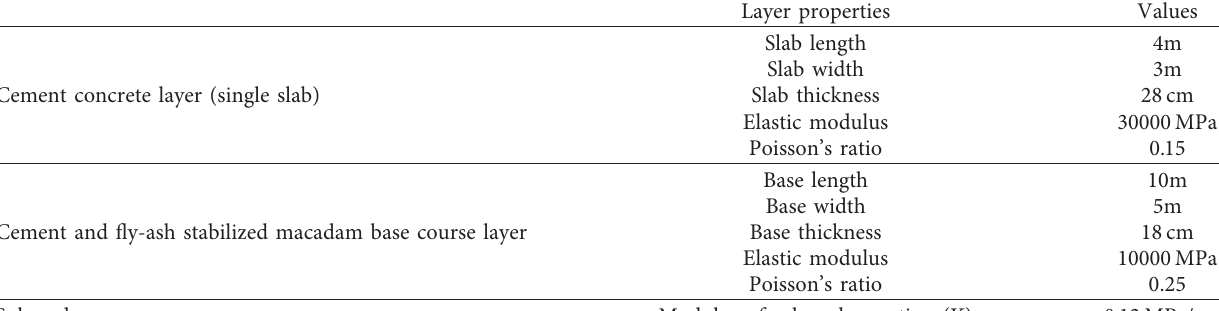
Table 1: The size and material properties of the FEA model.